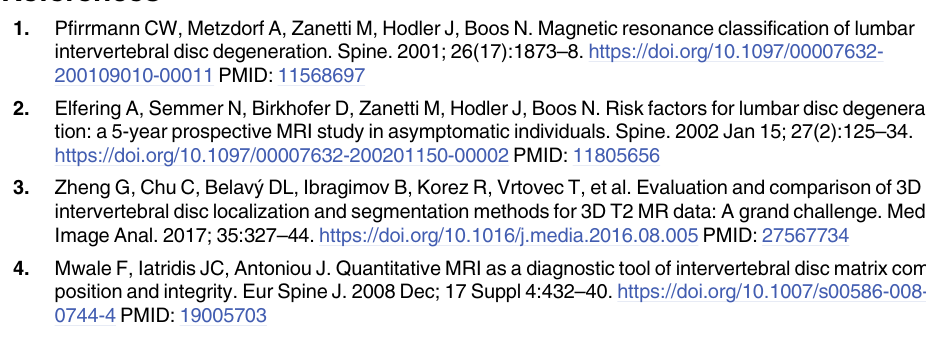
S1 Table. Results from Bland-Altman testing. � : 0.008 < p < 0.026 and indicates raw p-value on regression testing for linear bias. None of these P-values remain significant after adjustment for multiple comparisons via the false discovery rate method. Note that all lower limits remain below zero and all upper limits above zero, indicating no systematic mean